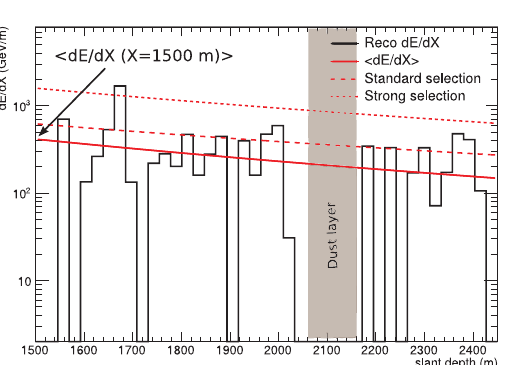
Figure 4: Energy loss reconstruction of an example air shower [5] event, where the solid red line demonstrates the average energy loss fit, the dashed red and dotted red lines indicate the standard and strong stochastics selection, respectively. The gray band is the approximate location of the dust layer for the slant depth of this particular event.